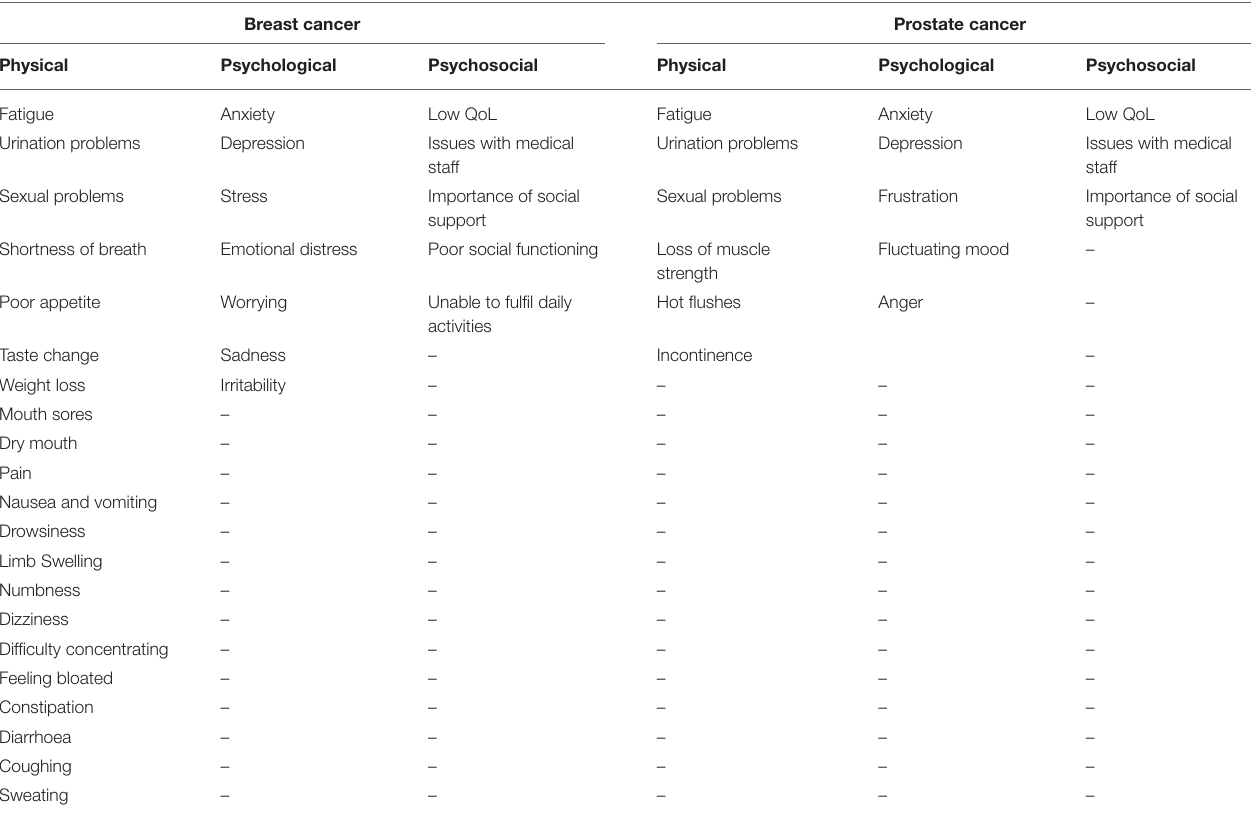
TABLE 3 | Common patient-reported issues after cancer